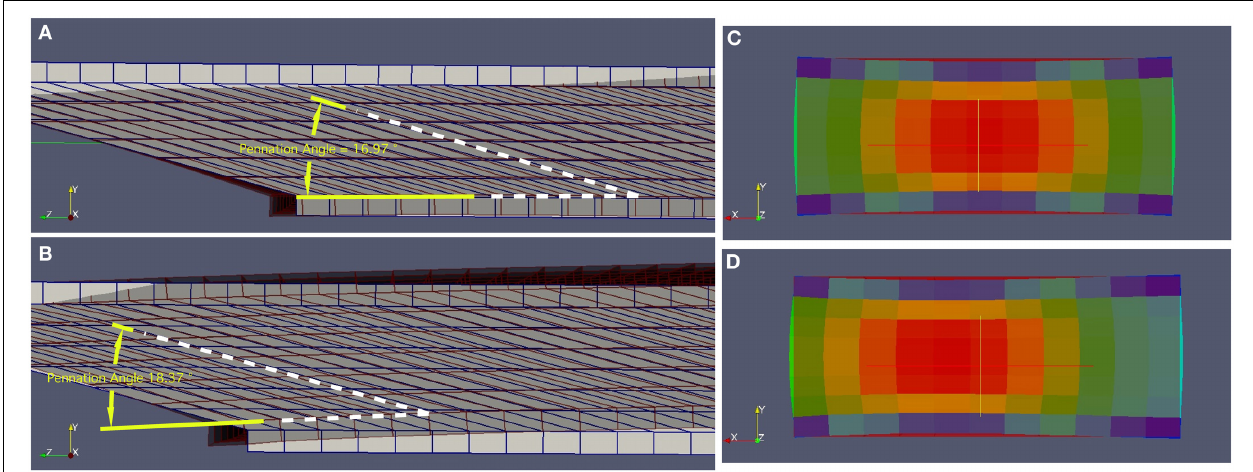
FIGURE 3 | Deformed (active) and undeformed (relaxed) geometries for (A) the Uniform activation pattern and (B) the proximal-distal activation pattern. These geometries are shown with pale areas and blue lines for the undeformed states, and darker areas and gray lines for the deformed states. Note that in the deformed states the pennation angle for the proximal-distal activation pattern (18.37 ◦ ) is larger than for the Uniform activation pattern. Transverse sections through the muscles are shown for the (C) Midline activation pattern, and (D) Medial-lateral activation pattern. In these panels